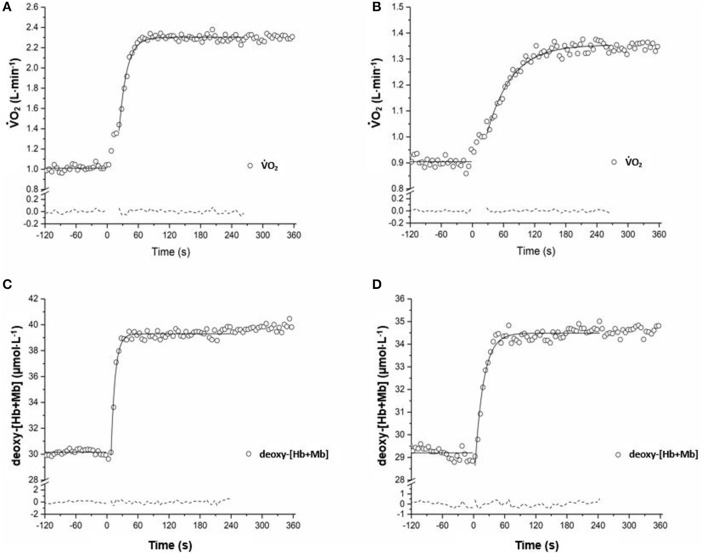
Adaptation of V˙O2
(A,B) and vastus lateralis deoxygenation (C,D) during the transition to exercise at a relative WR corresponding to ~80% of the gas exchange threshold in a representative YT and OI adult. Model fits of the data are displayed with a solid line, and residuals of the fit are displayed with a dashed line.